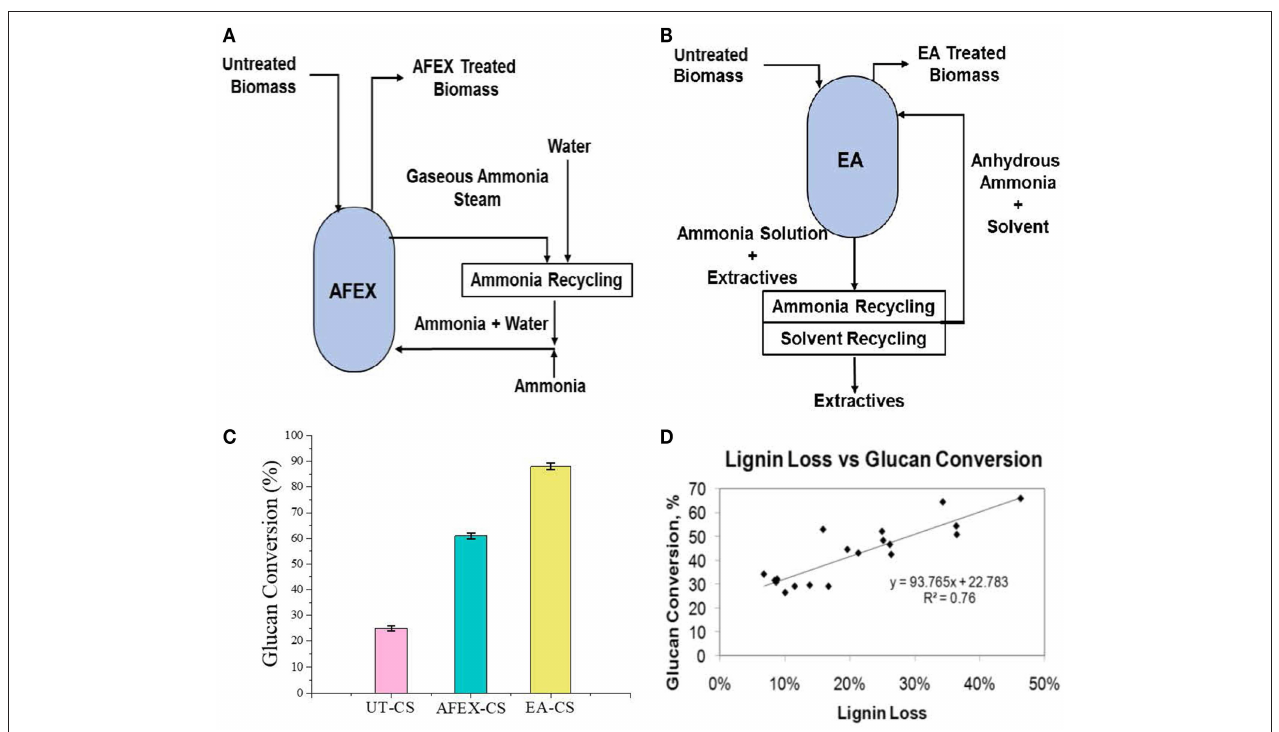
FIGURE 1 | Process flow diagram showing Extractive Ammonia (EA) and ammonia fiber expansion (AFEX) pretreatment and sugar conversion. Here, (A) reactor diagram of AFEX pretreatment, (B) reactor diagram of EA pretreatment, (C) glucan conversion of AFEX/EA pretreated CS, and (D) effect of sugar conversion as a function of lignin